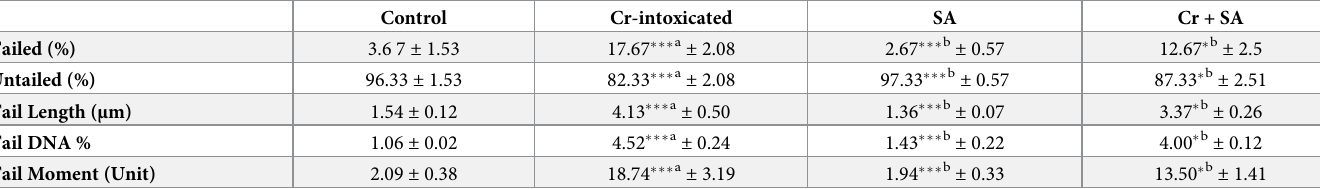
Table 2. Comet assay for assessment of DNA damage in the brain tissues of all experimental groups.